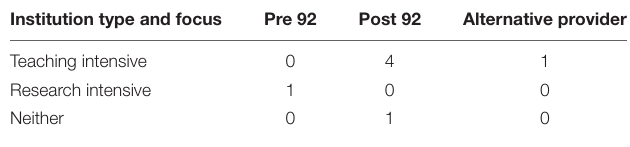
TABLE 1 | Type and focus of participating